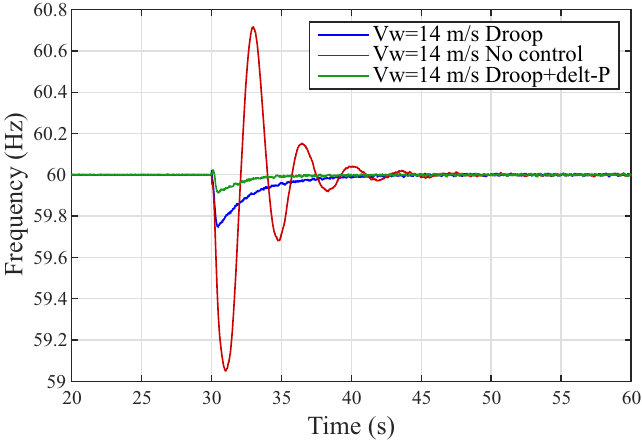
Figure 13. Frequency comparison for wind speed of 14 m/s.